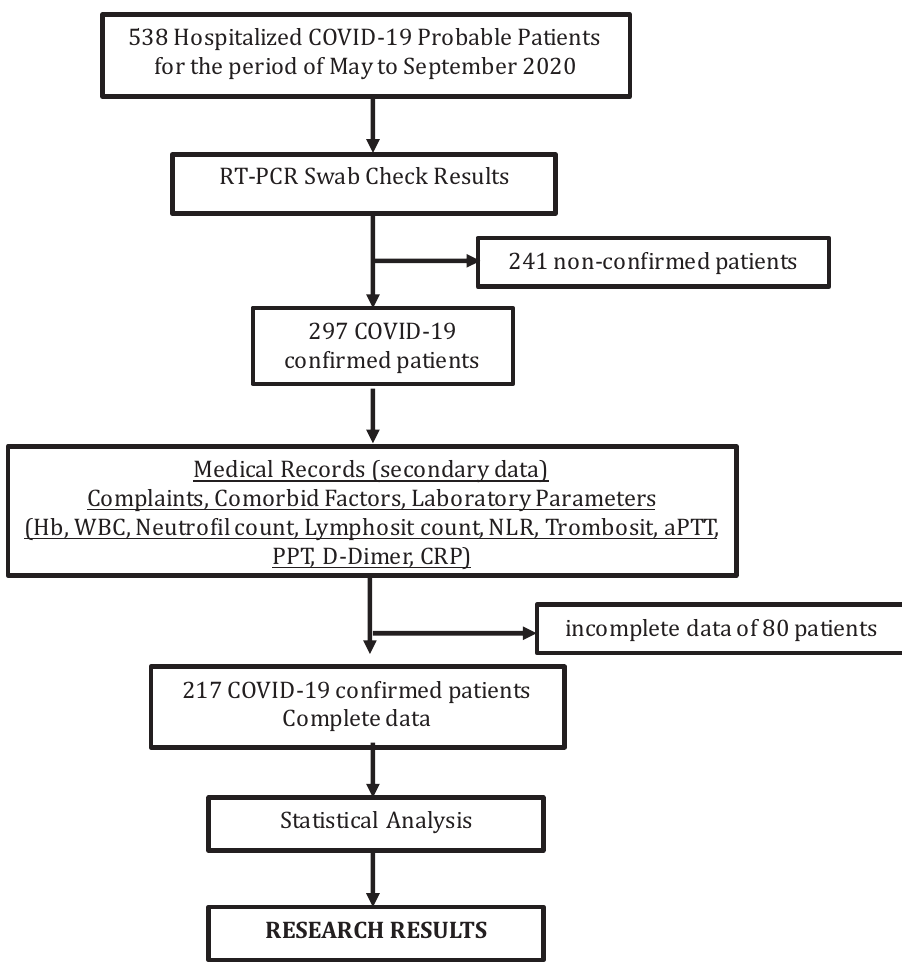
Figure 1. Patient COVID-19 data selection